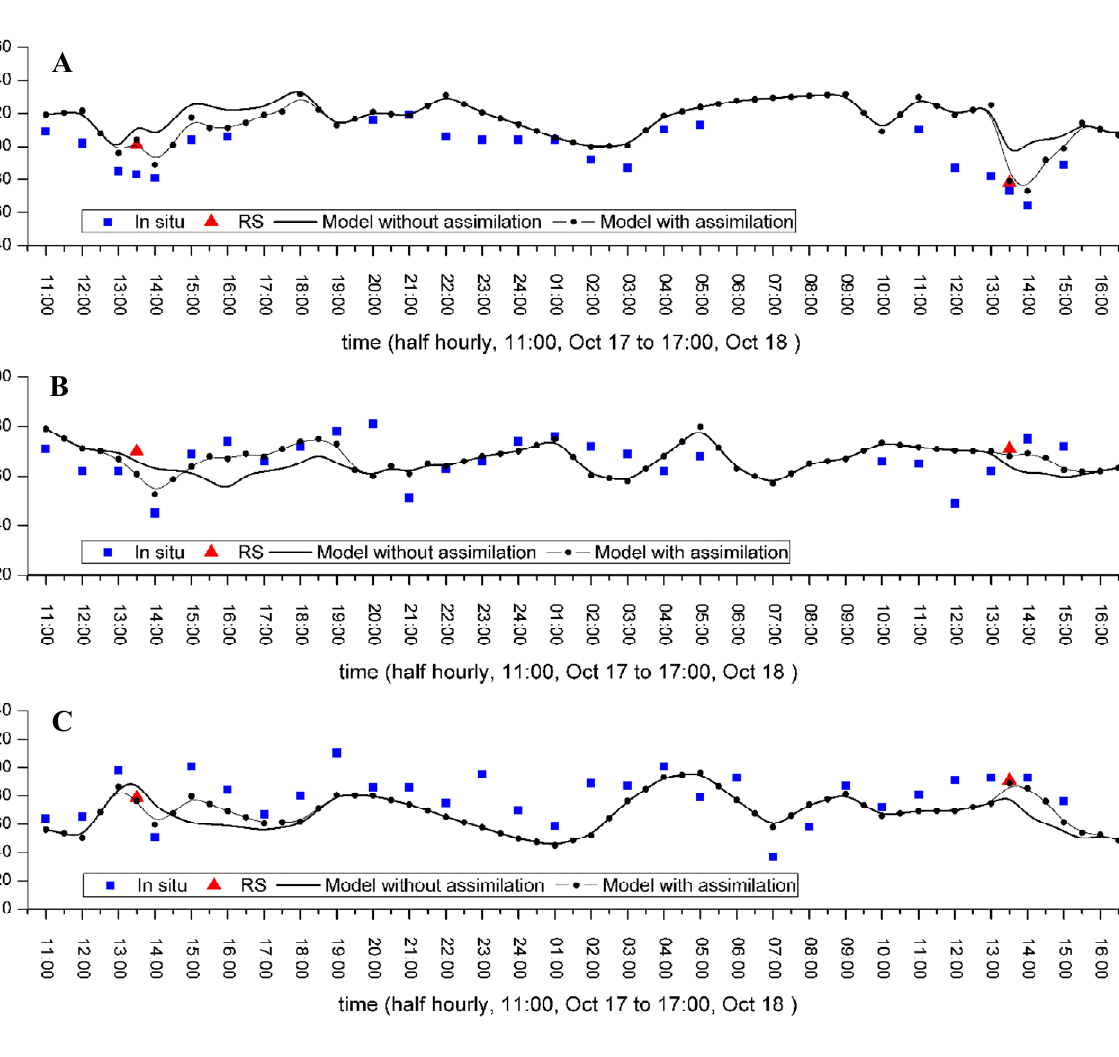
Figure 7. The time series of in situ measured surface sediment (half hourly) and forecasted sediment from the model with and without assimilation (half hourly) at sites S5 ( A ); S7 ( B ); and S8 ( C ). The remote sensing sediment at the assimilation time is also